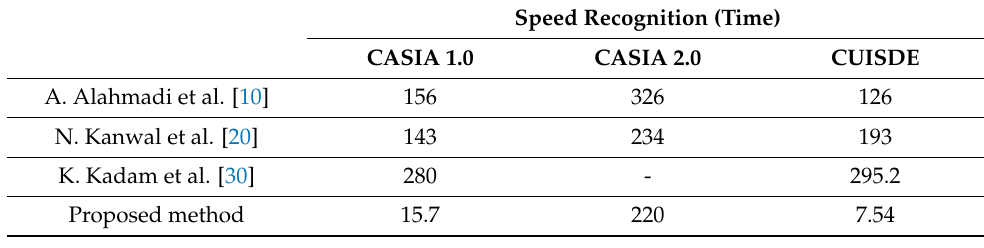
Table 6. A comparison of speed recognition (time) in the case of the proposed model and other